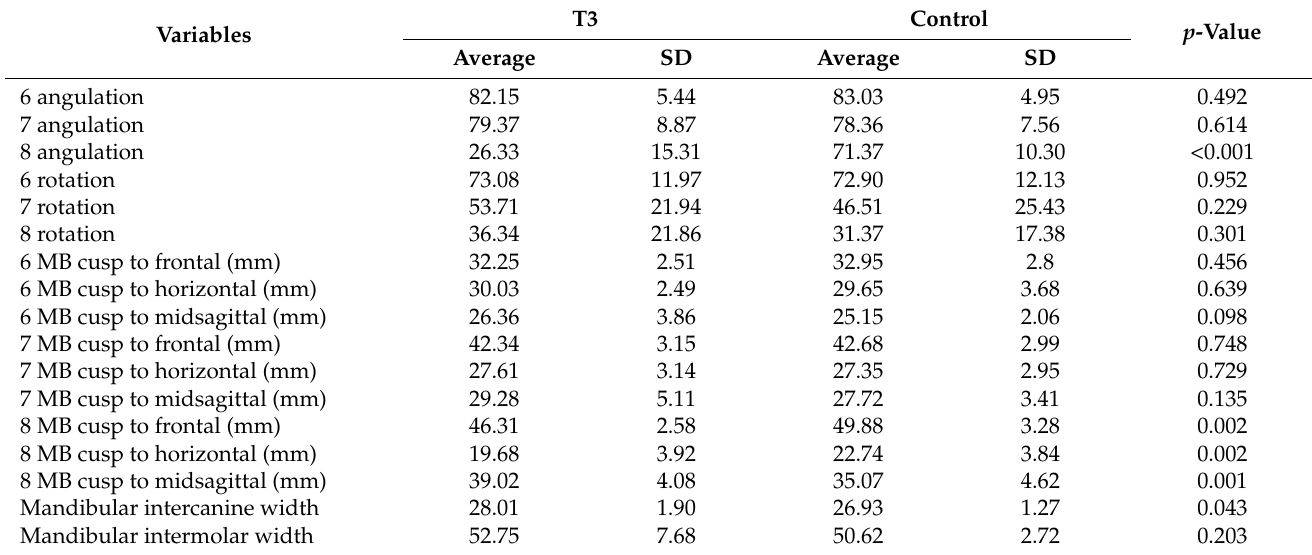
Table 4. Comparison of the measurements among long-term retention and the control